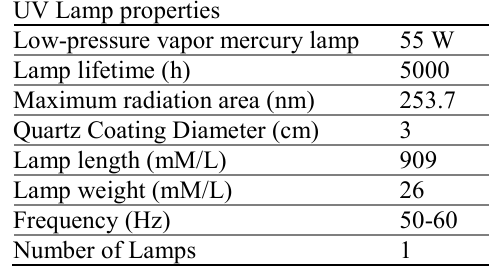
Table 1. UV Lamp